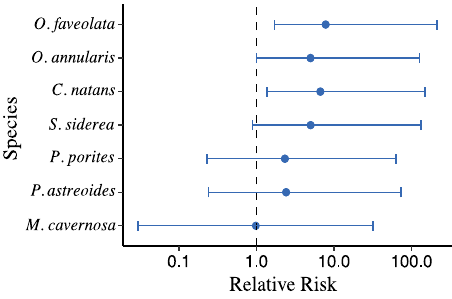
Fig. 4 Relative risk. The median relative risk the species will contract white plague disease with 95% credible